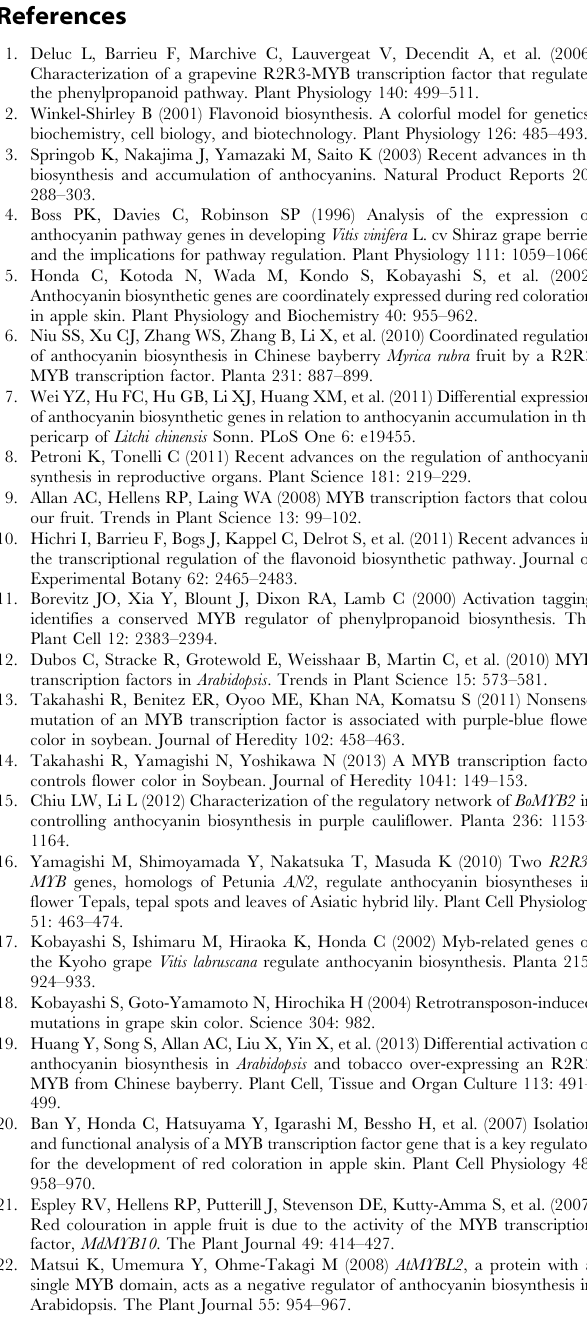
Figure S1 Expression of LcMYB2 in different tissues (A) and in the pericarp of developmental stages (B) of litchi cultivar ‘NMC’. Lcactin gene was used to normalize expression of the genes under identical conditions. The vertical bars represent standard error of three replicates. Figure S2 Images of tobacco lines containing LcMYB1 allele with CaMV 35S promoter. A-E: pigment formation during transformed process; F and G: pigmented leaves during seedling domestication.